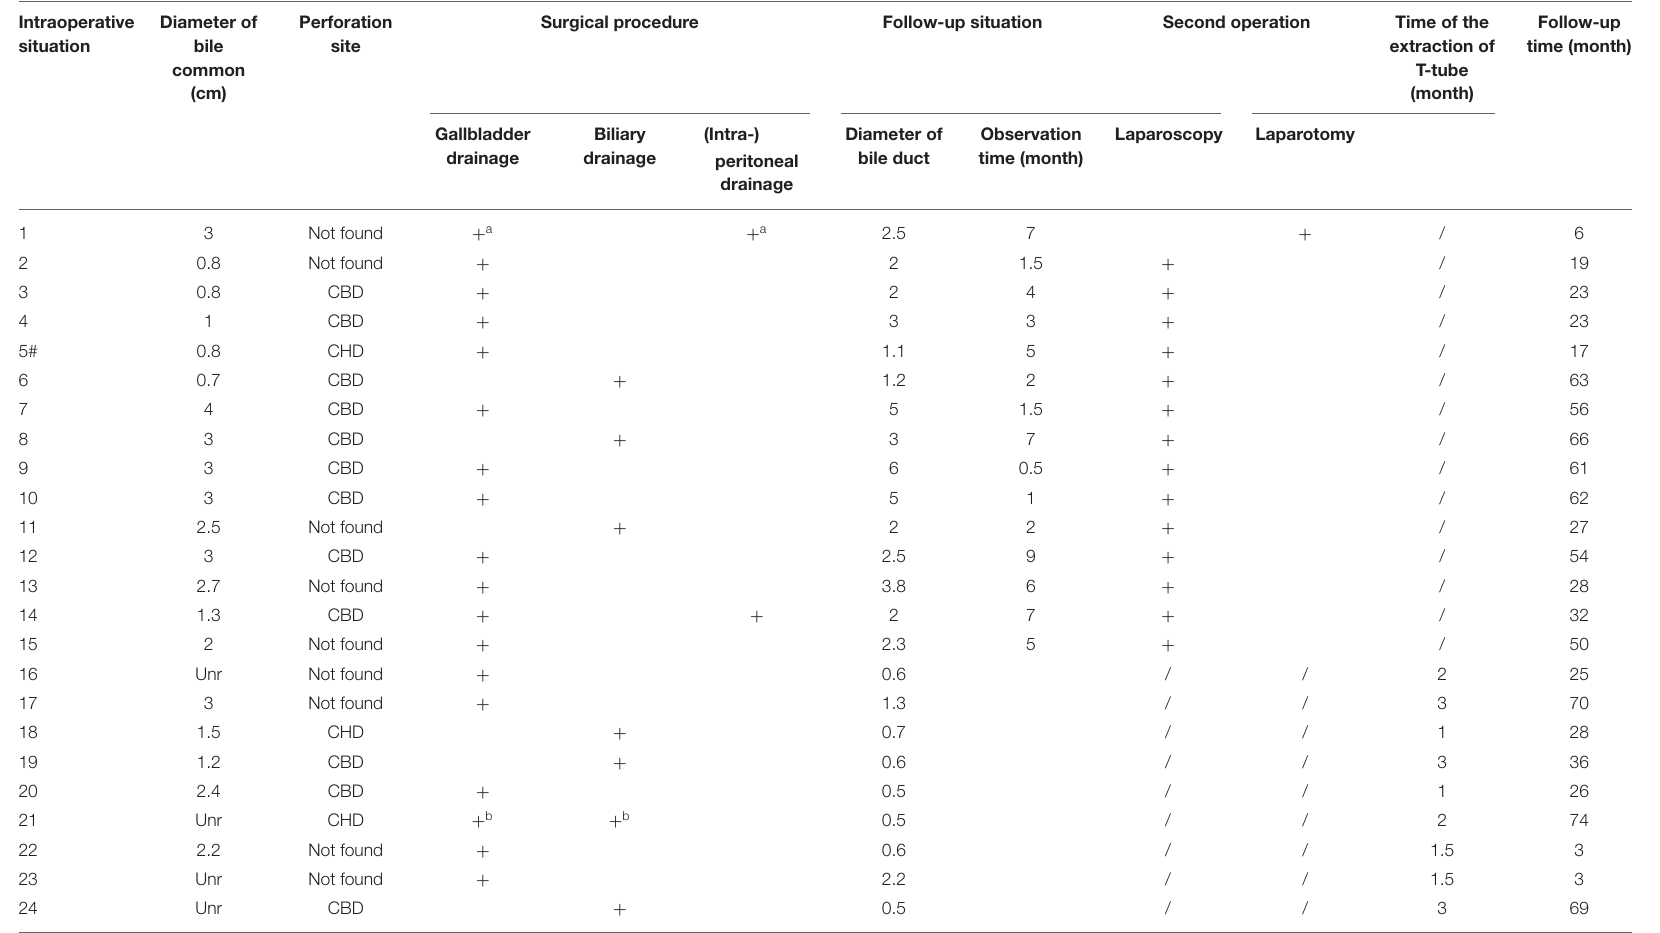
CHD, common hepatic duct; CBD, common bile duct; Unr, Unrecorded. a On this patient, the first operation was performed by laparoscopic gallbladder drainage, and on the 11th day after the operation, laparoscopic exploration was performed again because of the inadequate drainage, intraperitoneal drainage was respectively placed at the epiploic foramen, subhepatic region and splenic recess during the operation. b On this patient, the first operation was performed by laparoscopic gallbladder drainage, and on the 3th day after the operation, laparoscopic bile duct drainage was performed again because of the inadequate drainage. #This patient was hospitalized for cholangitis 1 month after